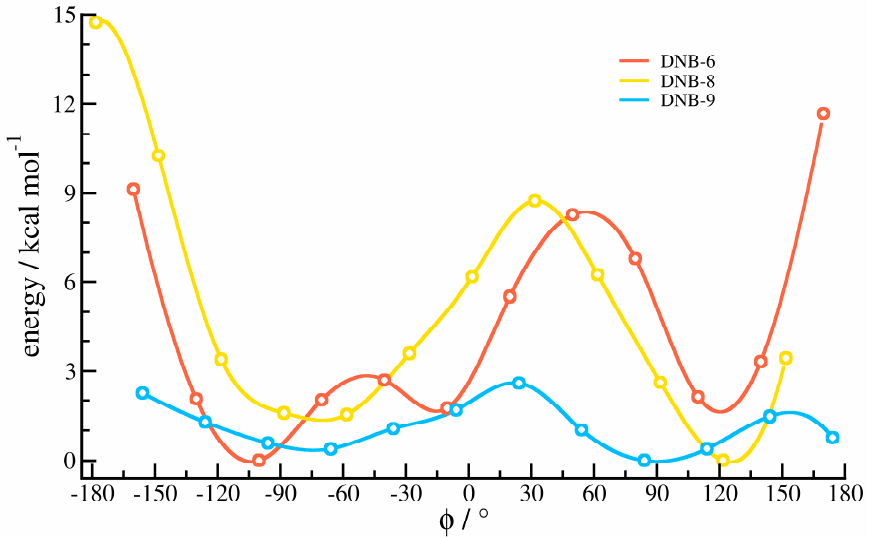
Figure 6. Relaxed potential energy surface scan around C*-C α bond of DNB-6 (red), DNB-8 (yellow) and DNB-9 (blue). Dihedral angle Φ is defined by atoms C β -C α -C*-N. Calculations were performed on M06-2X/aug-cc-pVDZ level of theory.